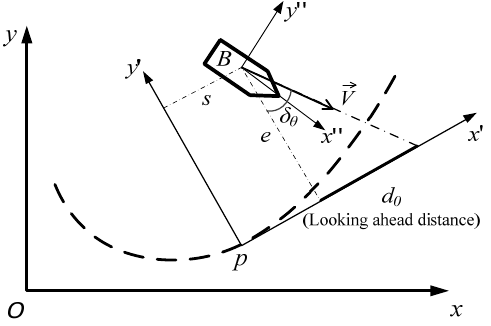
Figure 3. Guidance-based path-following scheme.